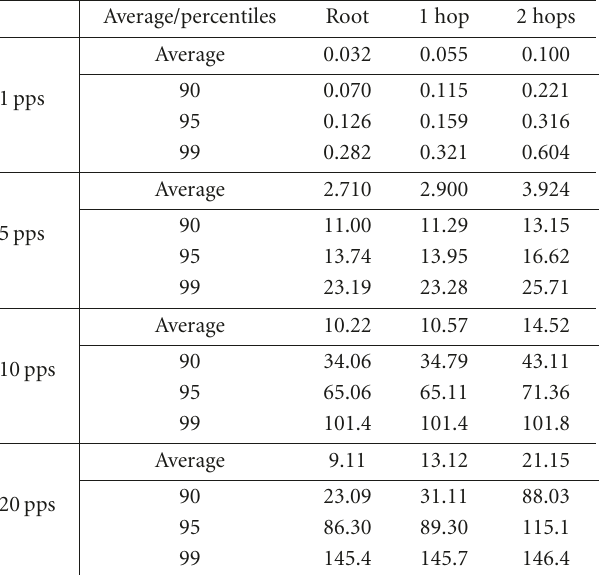
Table 1:Delays depending on the hop distance from root